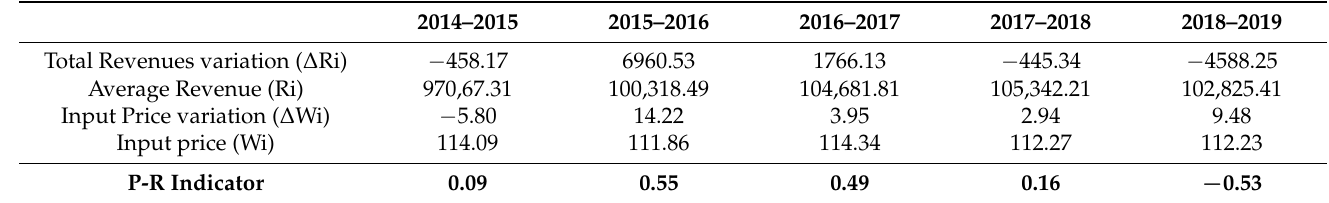
Table 7. P–R indicator for E.G. financial subsector